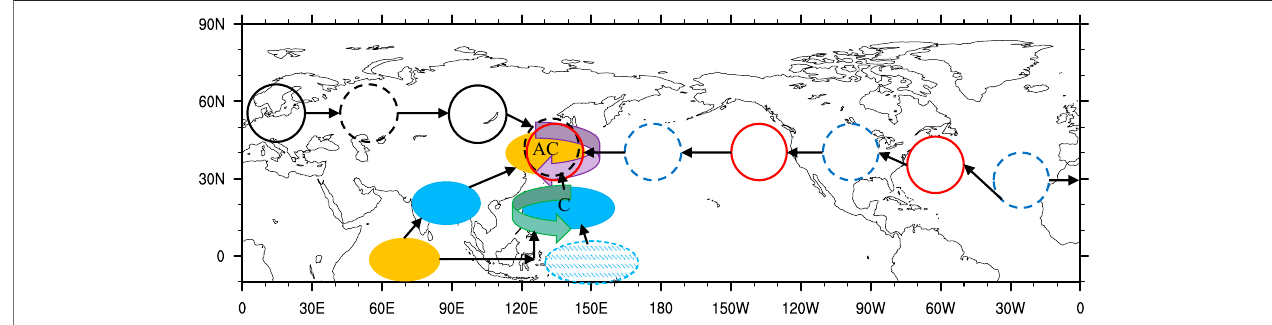
FIGURE 13 | Schematics for the atmospheric LFO affecting the meridional activity of the WPSH on sub-seasonal time scale. Red/blue hollow circles represent positive/negative Z500 wave train; black solid/dashed circle denoting positive/negative low frequency PV wave train. Yellow/blue shading ellipses denote weak/strong low frequency convective anomalies; ellipse fi lled with blue dotted line represents original strong low frequency convective anomaly. Green/purple arrows denote low frequency cyclone/anticyclone.